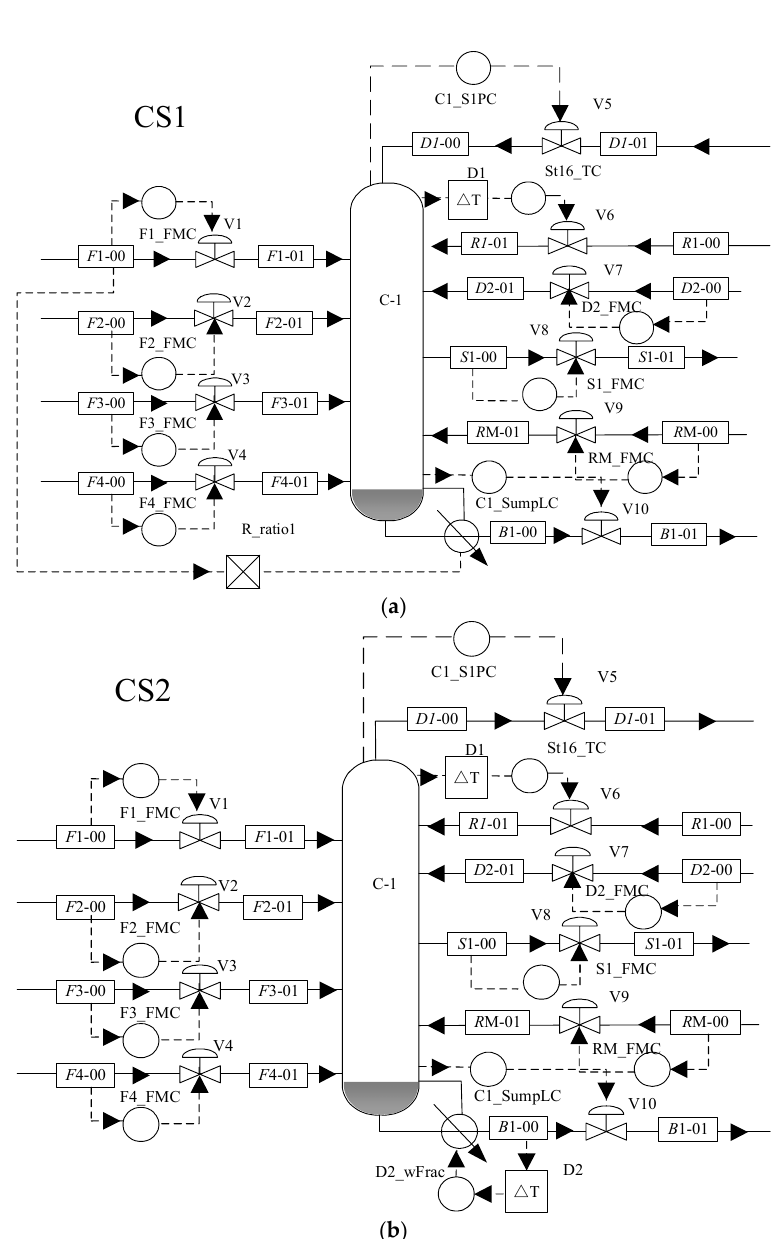
Figure 9. Control strategies for the HAc dehydration system. ( a ) Control strategy 1 and ( b ) control strategy 2.